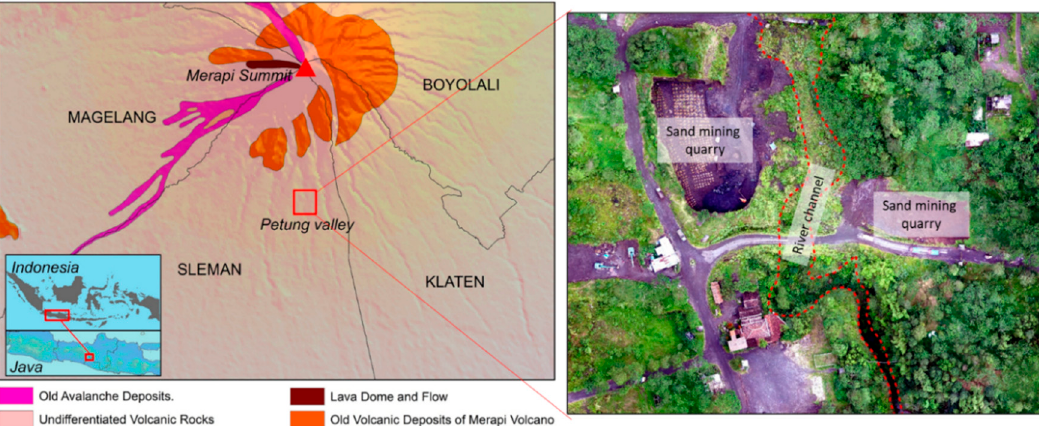
Figure 2. The abandoned channel of Petung River, on the southern flank of Merapi after lahar event in 2011. It is located in undifferentiated volcanic rock formation ( left ). An aerial image of Petung River segment was taken in 2018 during the rainy season ( right ) (drone image by Handayani, 2018).